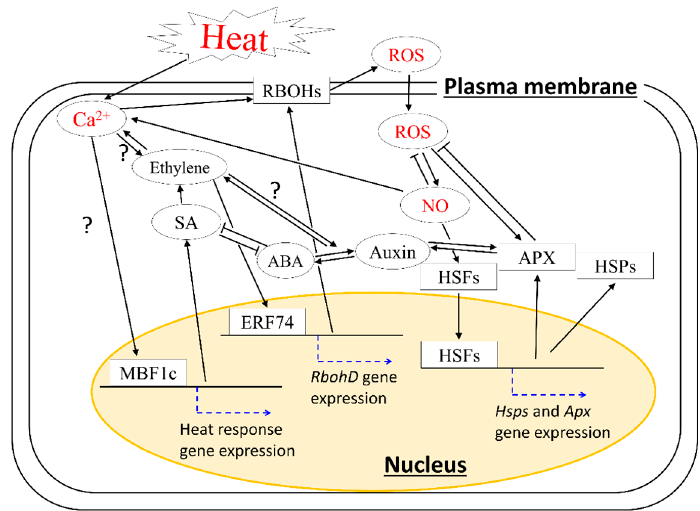
Figure 1. Simplified model of signaling pathway governing basal thermotolerance in plants. Important pathways involving heat shock proteins (HSPs), reactive oxygen species (ROS)-scavenging enzymes (such as ascorbate peroxidases (APXs)), hormones, and multiprotein bridging factor 1c (MBF1c) might be modulated by a feedback loop of Ca 2+ , ROS, and nitric oxide (NO). Rectangles indicate proteins; ellipses indicate other signaling molecules, e.g., Ca 2+ ions, hormones, ROS, and NO; black arrows indicate positive regulation; T-shaped lines indicate negative regulation; blue dotted arrows indicate activation of gene expression; yellow circle indicates nucleus. Heat stimuli and key signaling molecules (Ca 2+, ROS and NO) are indicated in red characters. Names of cellular components are indicated in underlined characters. The pathways that can be hypothesized but not clearly evidenced in previous studies are marked with “?”.